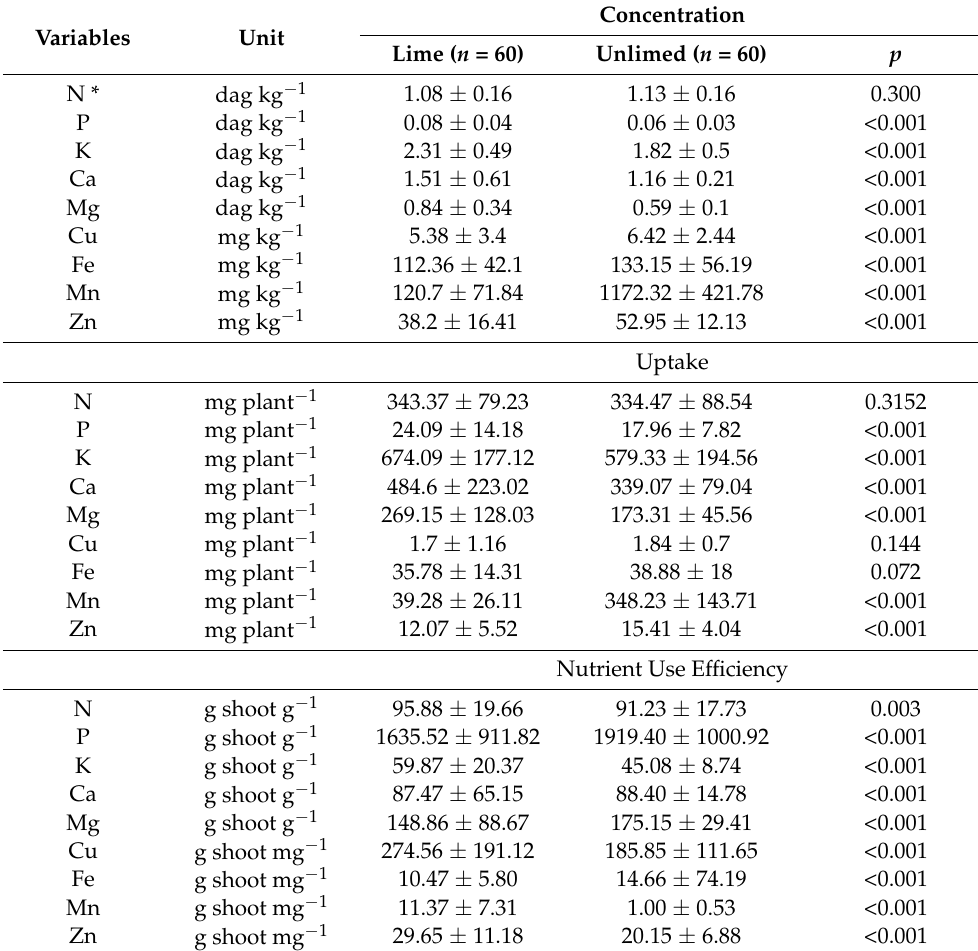
Table 4. Effect of soil acidity on concentration, uptake and nutrient use efficiency of N, P, K, Ca, Mg, Cu, Fe, Mn, and Zn in juvenile cacao